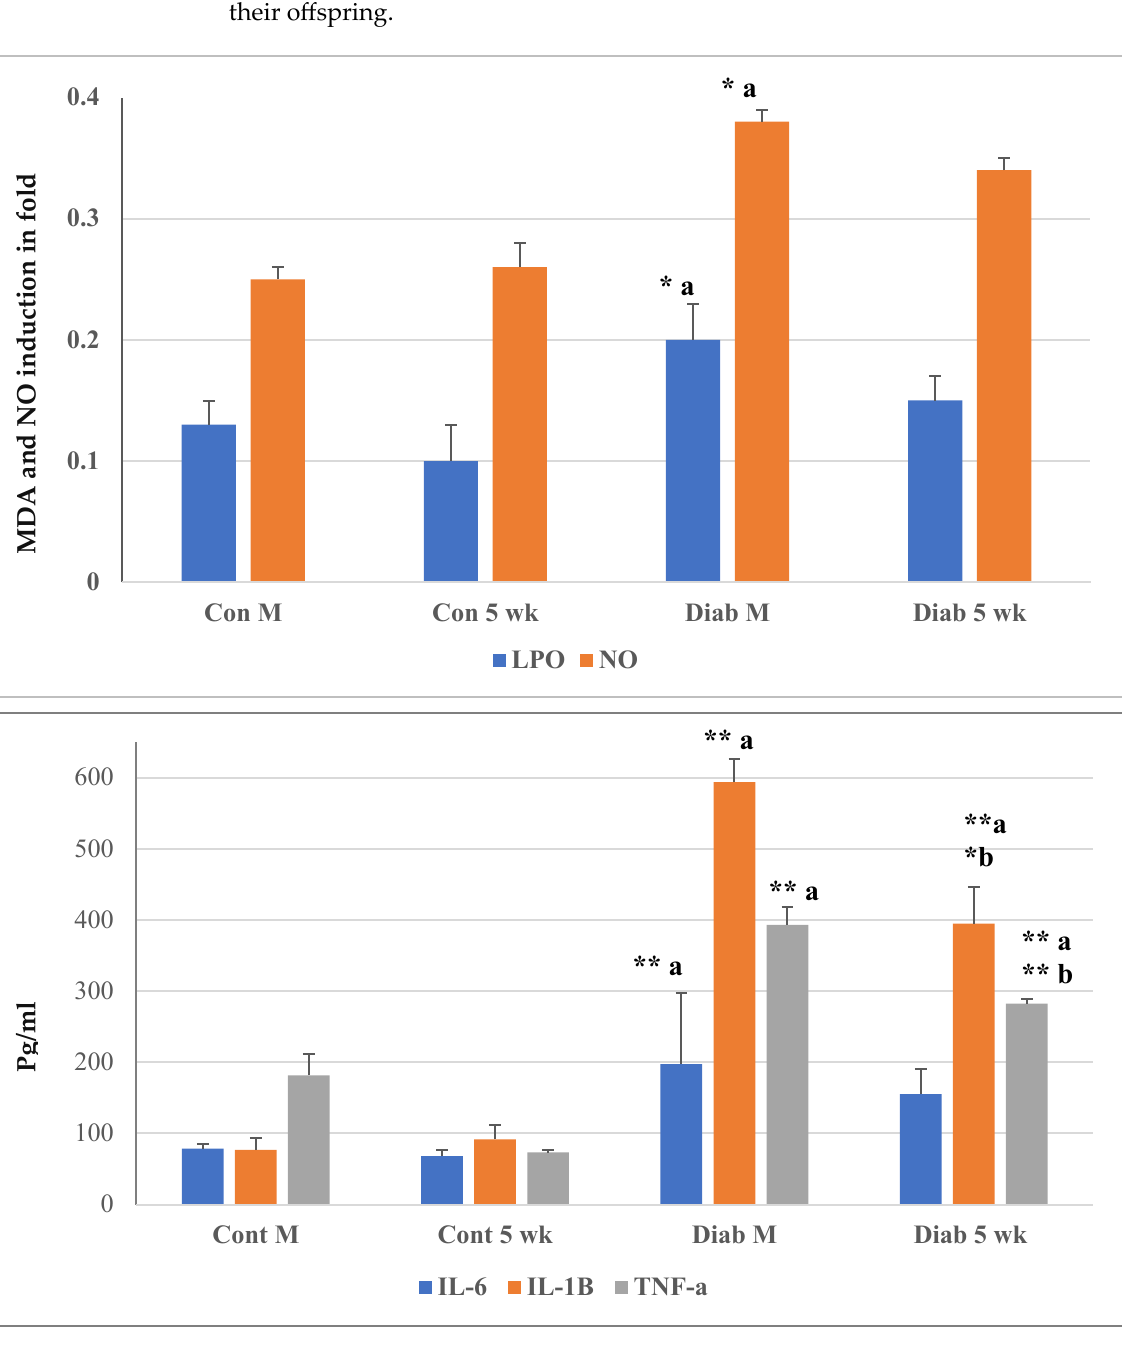
Figure 1. Untreated diabetes induces oxidative stress and inflammation in mothers and inflamma‑ tory response in 5‑week‑old offspring. ( A ). Lipid peroxidation products, MDA and NO induction in control and diabetic mothers and their offspring. ( B ). Untreated diabetes during pregnancy affects the proinflammatory cytokines level in serum of mothers and offspring. p ≤ 0.05 * significant vari‑ ation, p ≤ 0.01 ** high significant variation. a versus appropriate control; (control mothers, Con M and 5‑week‑old offspring, con 5 wk), b relative to diabetic mothers (Diab M, n =